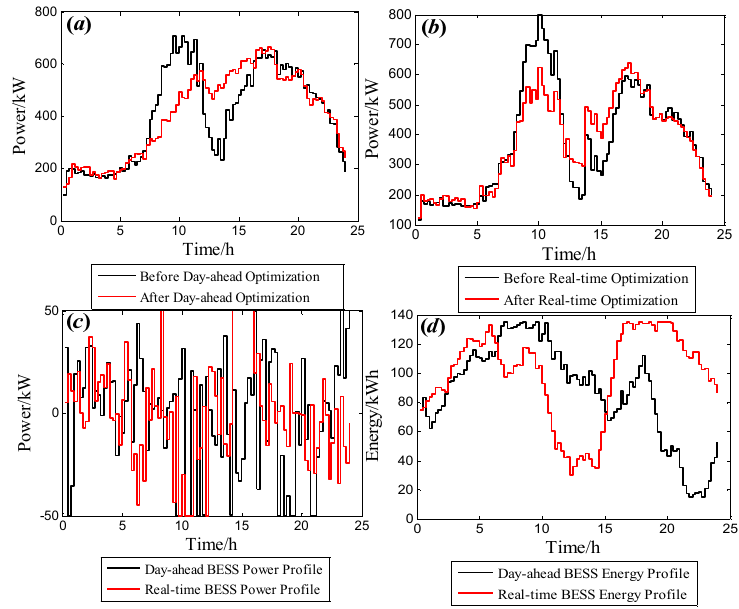
Figure 9. ( a ) Load profiles of before and after combined day-ahead optimizing (with EVs); ( b ) load profiles of before and after combined real-time optimizing (with EVs); ( c ) BESS operation power profiles of day-ahead and real-time (with EVs); ( d ) BESS operation energy profiles of day-ahead and real-time (with EVs).